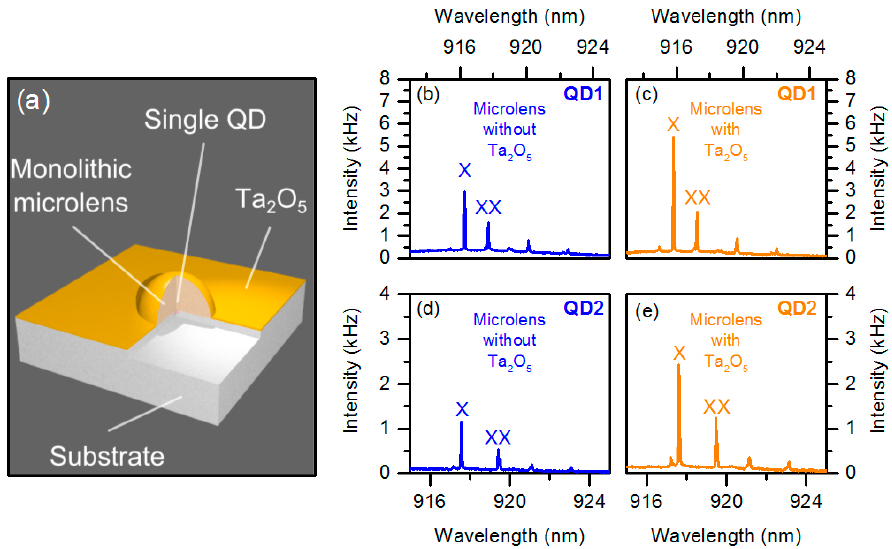
Figure 1. ( a ) Schematic of a deterministic quantum dot (QD) microlens device. To enhance the photon-extraction efficiency (PEE) the microlens-surface is coated with a thin layer of Ta 2 O 5 ( n = 2.1) acting as anti-reflection (AR) coating; ( b , c , d , e ) micro-photoluminescence (µPL) spectra measured at saturation of X emission from two QD microlenses before and after coating with Ta 2 O 5 .